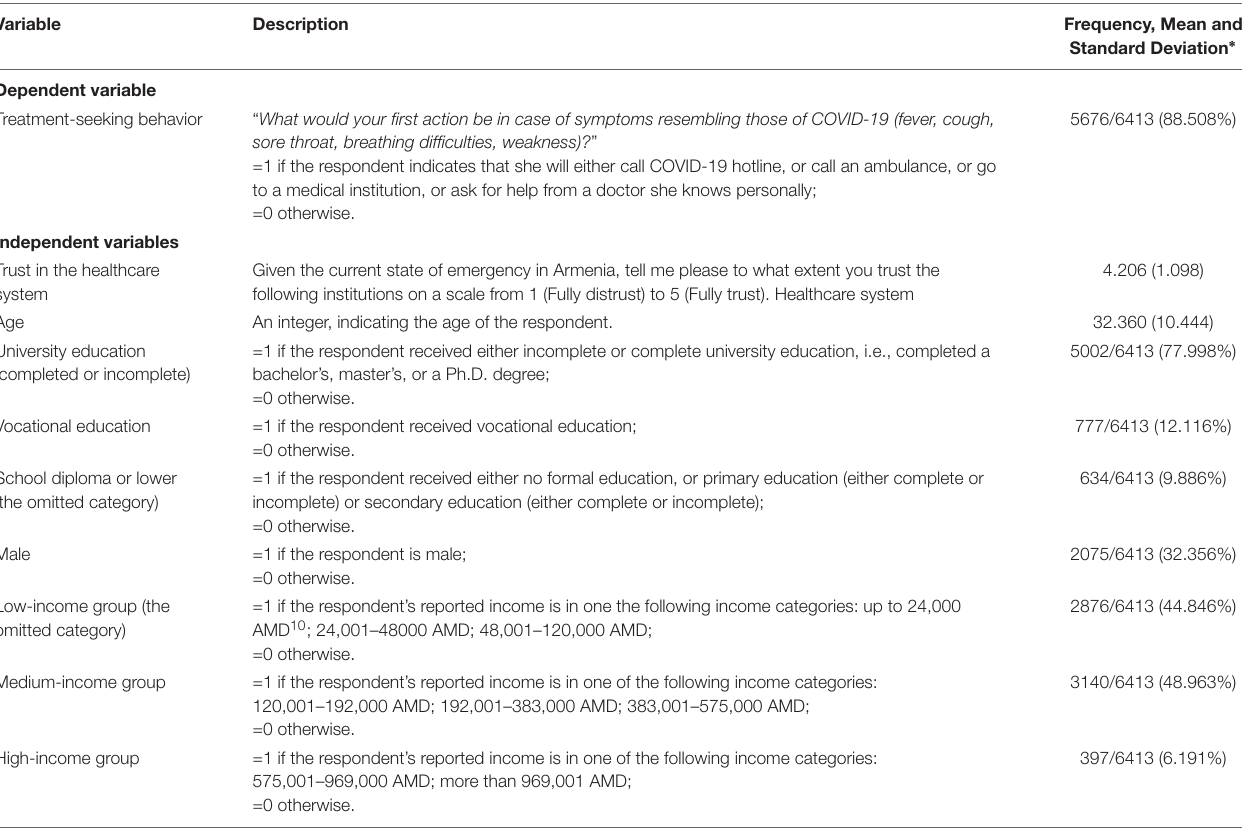
TABLE 1 | Variables and descriptive statistics.